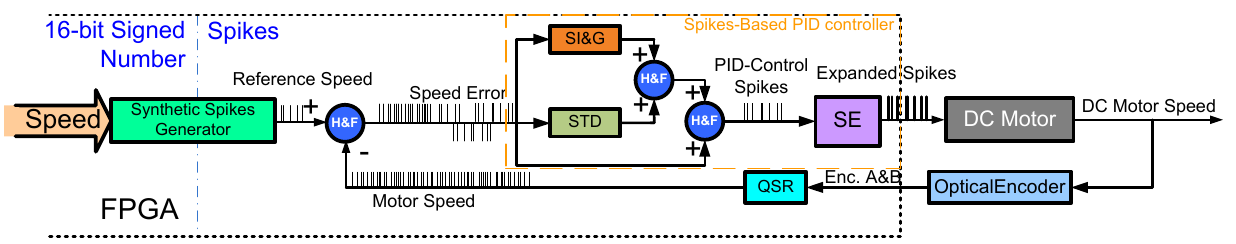
Figure 2. Spikes-based PID controller internal building